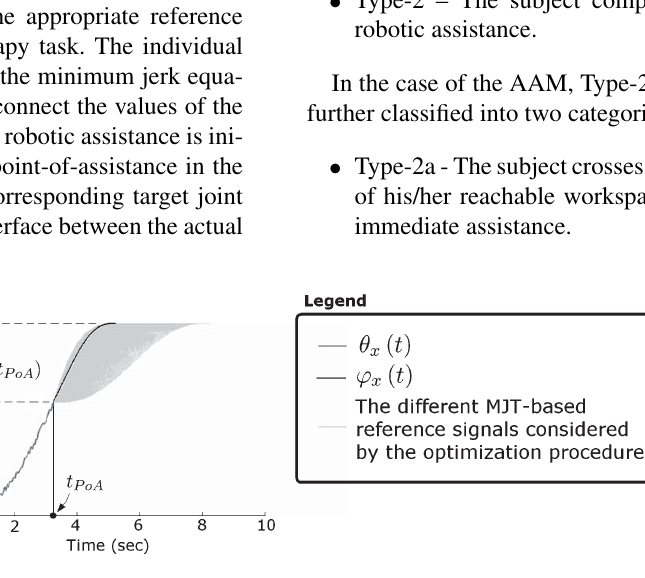
Fig. 5. Demonstration of the optimization procedure used for generating the reference signal for the inner-loop position controllers in